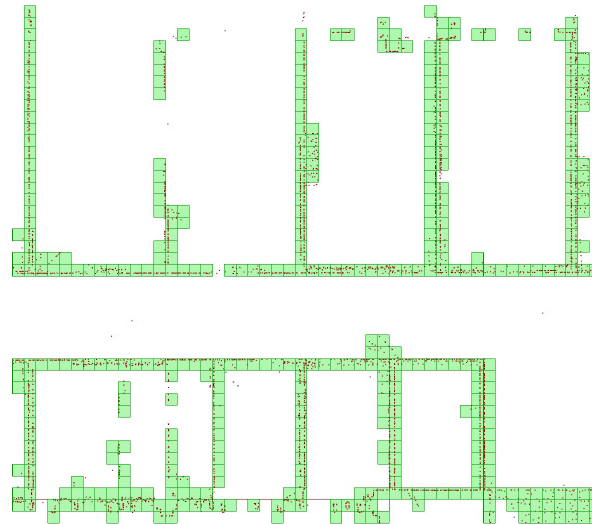
Figure 6 . Grid cells coinciding with points from the point cloud In the next step, valid cells are classified according to the orientation of the neighbours and the detachment. Technically, this is done by analysing the coordinates of the cell centres. Large groups of cells the centres of which have the same X coordinates indicate a wall that has the Y direction and vice versa (Functions "Sort List", "Delete Consecutive", "Member Index", and "Partition List"). Small, detached groups of cells are ignored (Figure 7).